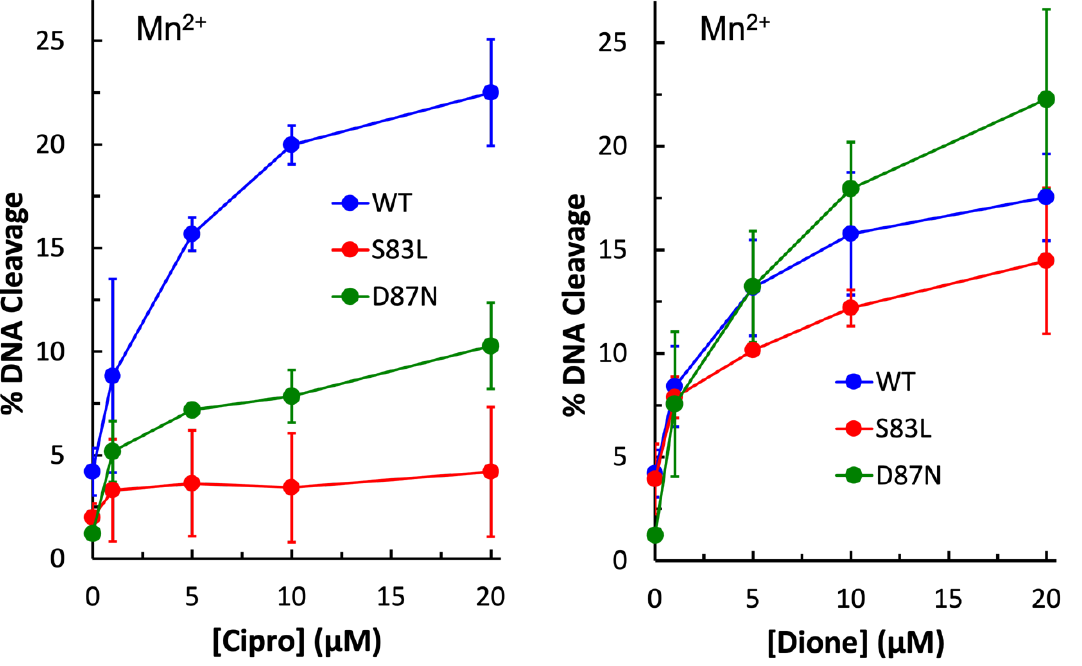
Figure 4. Plasmid DNA cleavage induced by wild-type (blue), GyrA S83L (red), and GyrA D87N (green) gyrase enzymes in the presence of 0 – 20 µM ciprofloxacin ( left ) or quinazolinedione ( right ). Mn 2+ was the metal ion. Error bars represent the standard deviation of three or more independent experiments.